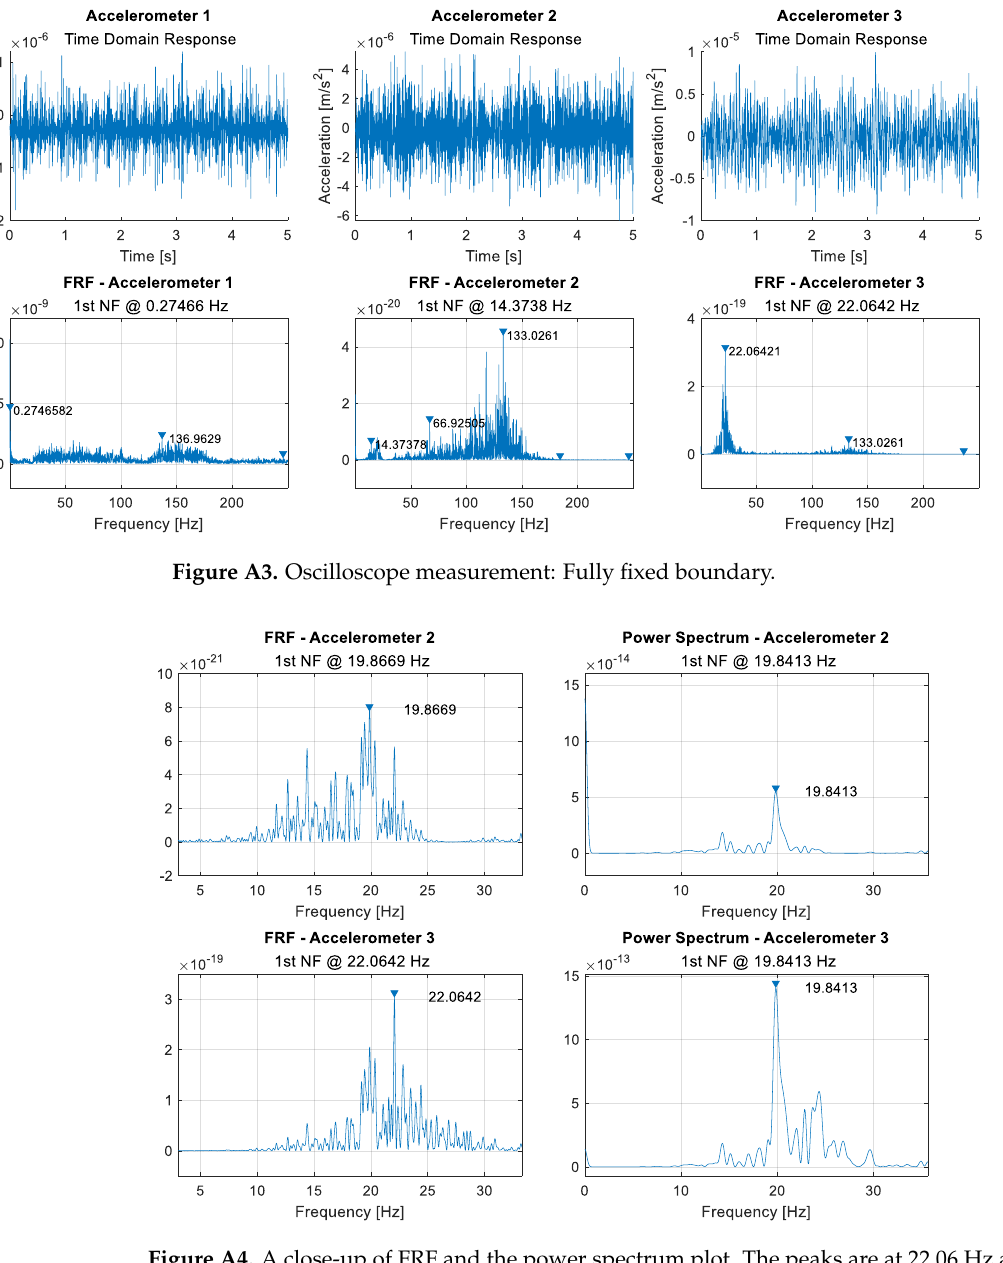
Figure A4. A close-up of FRF and the power spectrum plot. The peaks are at 22.06 Hz and 19.89 Hz from FRF and 23.9 Hz and 19.7 Hz for power spectrum, respectively.